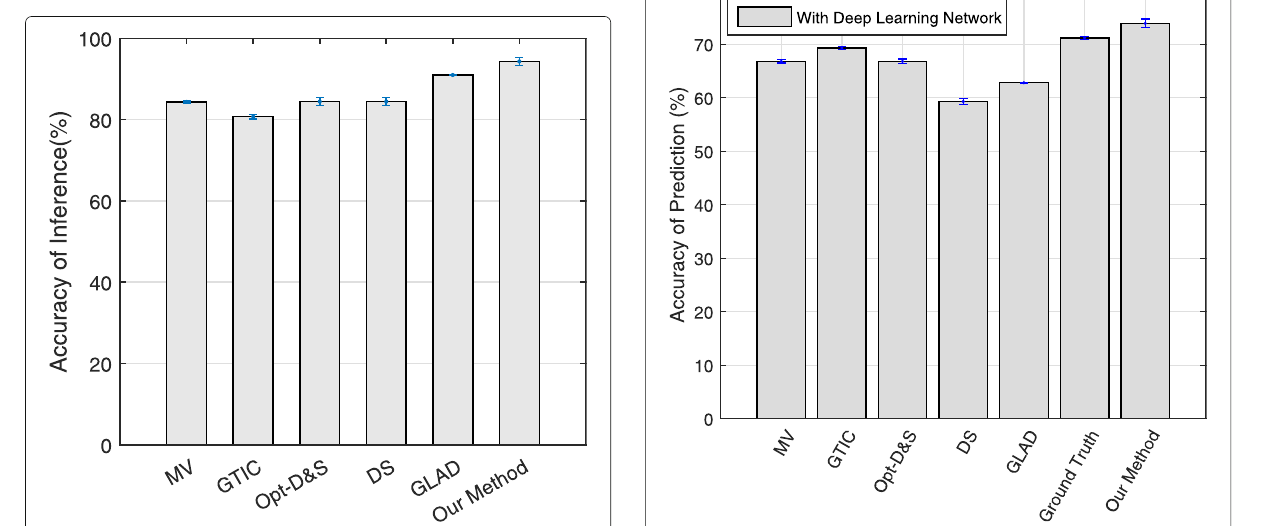
Fig. 7 Accuracy comparison. Comparison results in accuracy for six aggregation methods